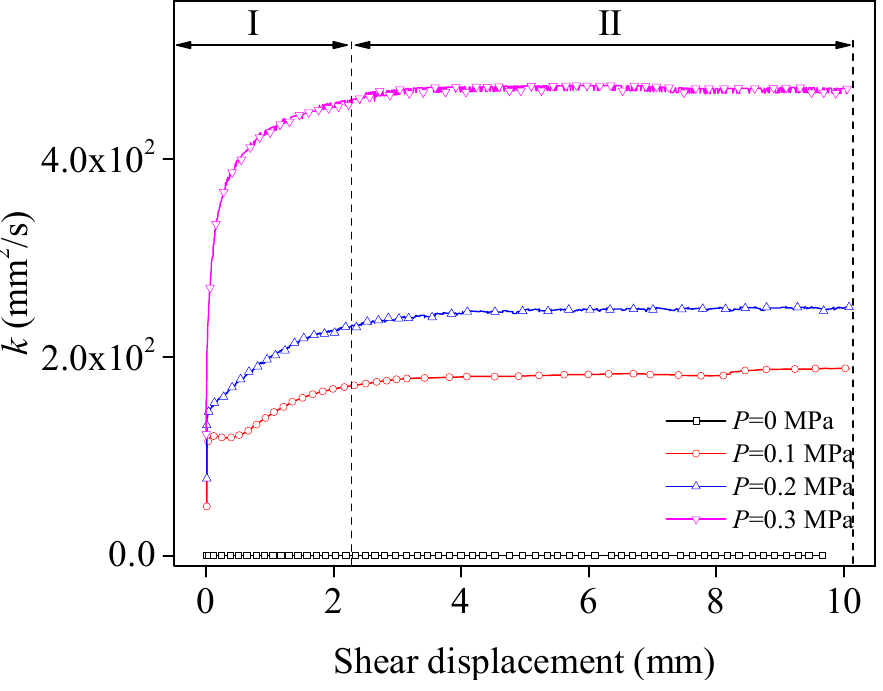
Figure 11. Evolution of transmissivity.